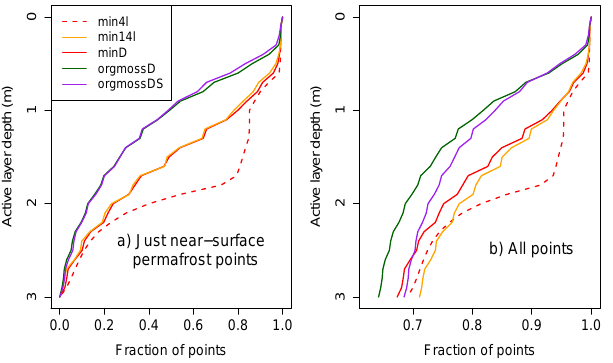
Figure 9. The vertical distribution of permafrost, shown by the frac- tion of points for which the soil thaws below a given depth. (a) Near- surface permafrost points only: this includes only those points with ALT less than 3m, and hence 0% of them thaw to below 3m. (b) All points are included, so about 70% thaw to greater than 3m or have no permafrost at all. There is one point for each grid cell for each year of the historical simulation.